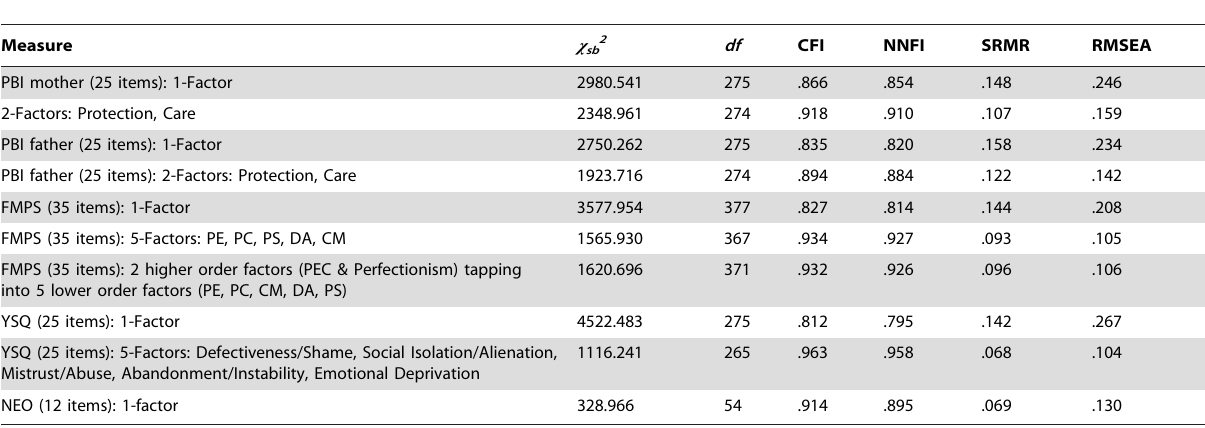
Table 3. Goodness-of-fit Statistics for Confirmatory Analyses of the PBI, FMPS, YS-SF and NEO-FFI.